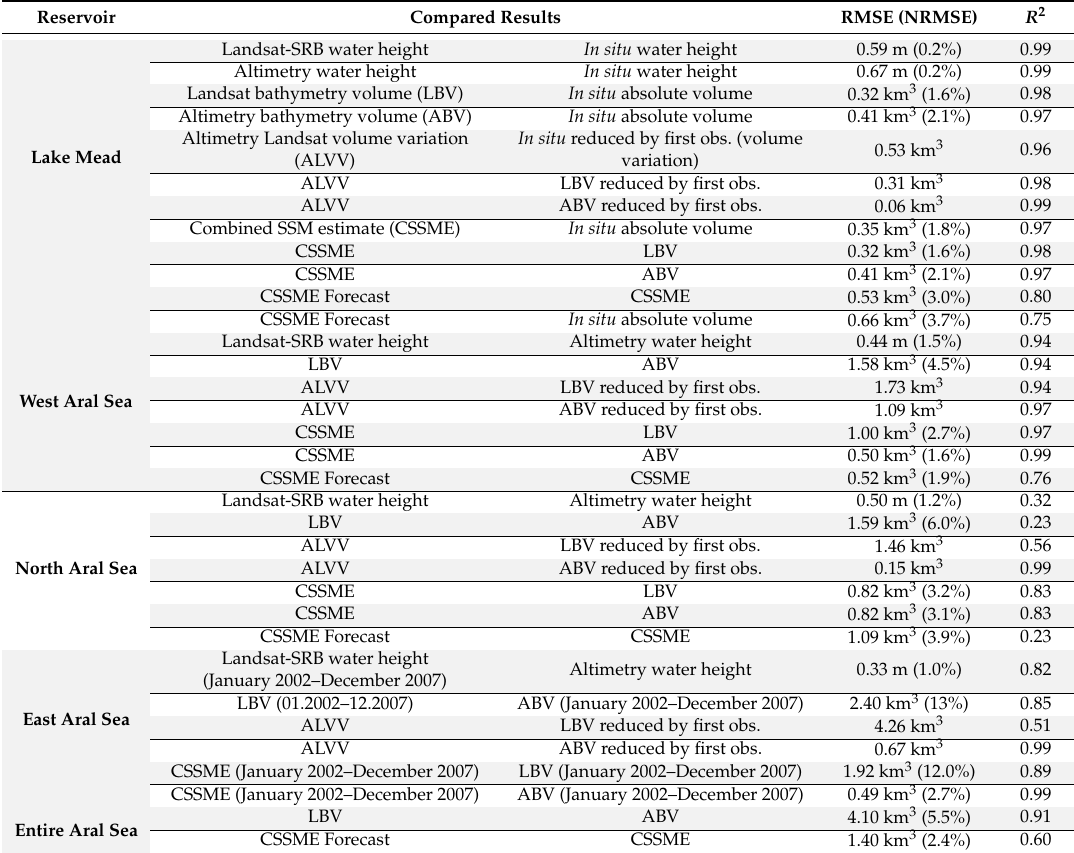
Table 2. Comparison of results from all the reservoirs by root mean square error (RMSE) and coefficient of determination ( R 2